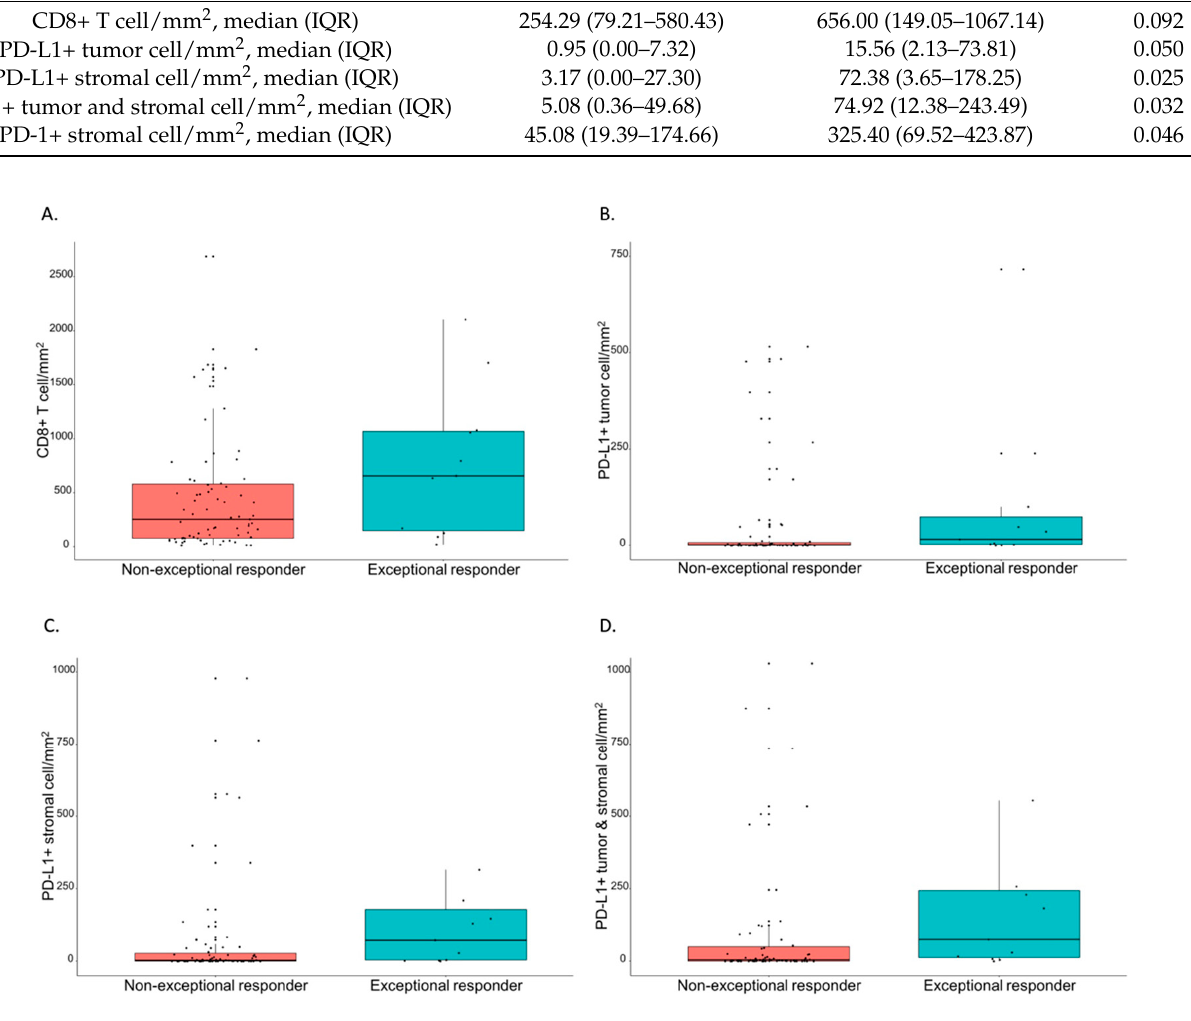
Table 2. Immune profile of the BRAF-MT tumors in the non-good and good responder groups.